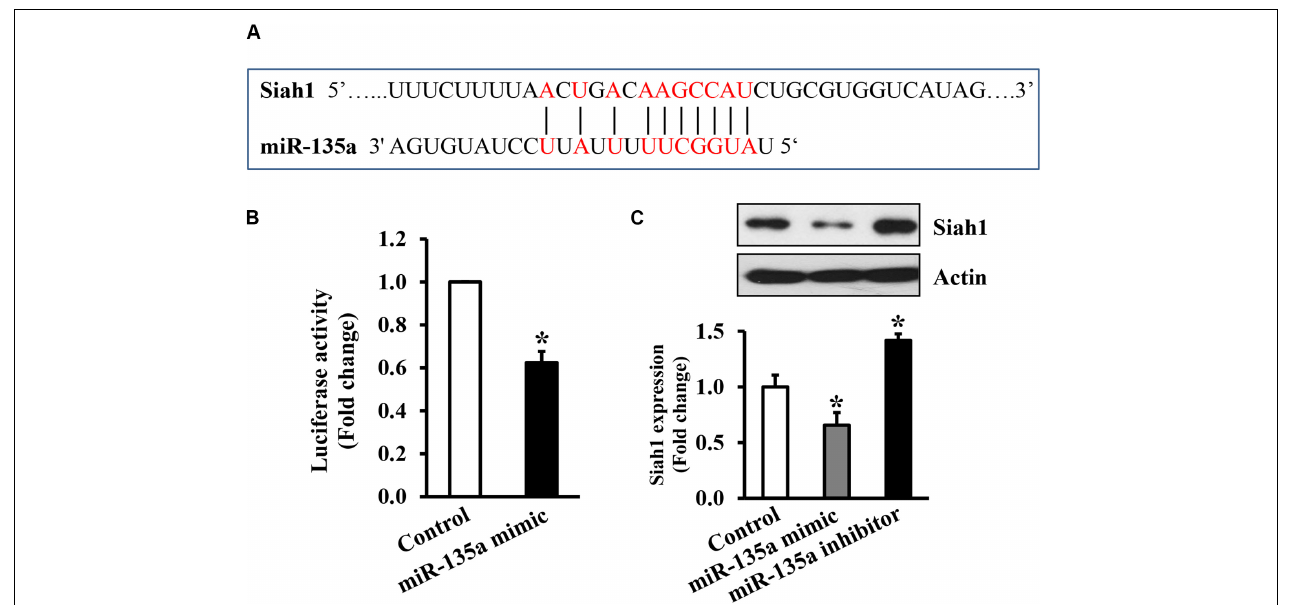
FIGURE 2 | Siah1 is the direct target of miR-135a in neural crest cells (NCCs). (A) The predicted binding sites of miR-135a in the 3 (cid:48) -UTR of Siah1 mRNA. (B) Luciferase reporter assays for the binding of miR-135a to the 3 (cid:48) -UTR of Siah1 in NCCs. (C) Western bolt analysis of the protein expression of Siah1 in NCCs transfected with miR-135a mimics or inhibitors for 48 h. Data are expressed as fold change over control and represent the mean ± SD of three separate experiments. * p < 0.05 vs. control.